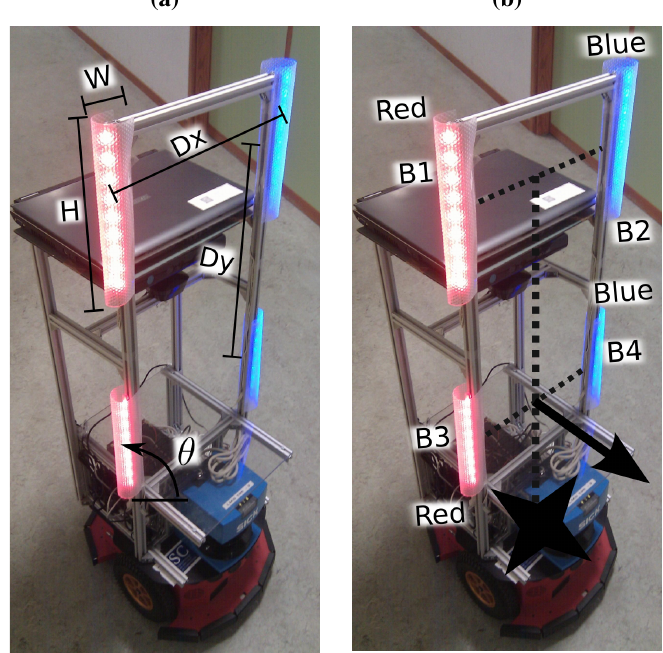
Figure 11. ( a ) Geometric properties taken into account in the pattern matching process: Blob width W , height H , and angle with respect to the horizontal axis θ , to measure parallelism among blobs, and horizontal ( D Robot position and orientation